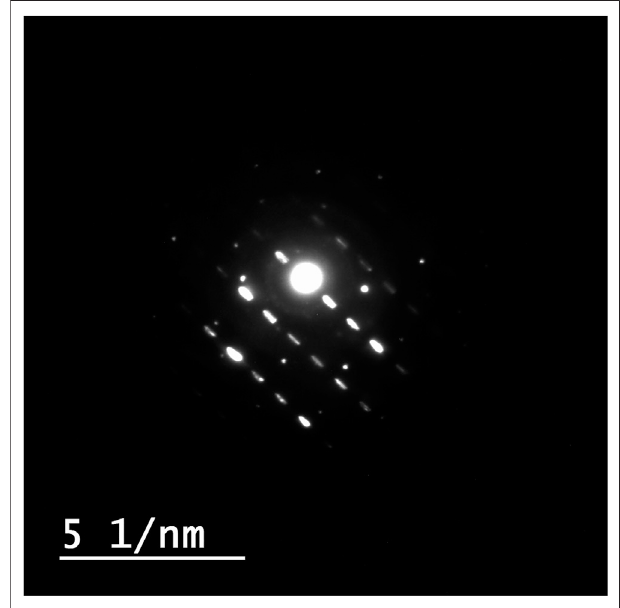
FIGURE 4 | Diffraction index of ZnO nanorods